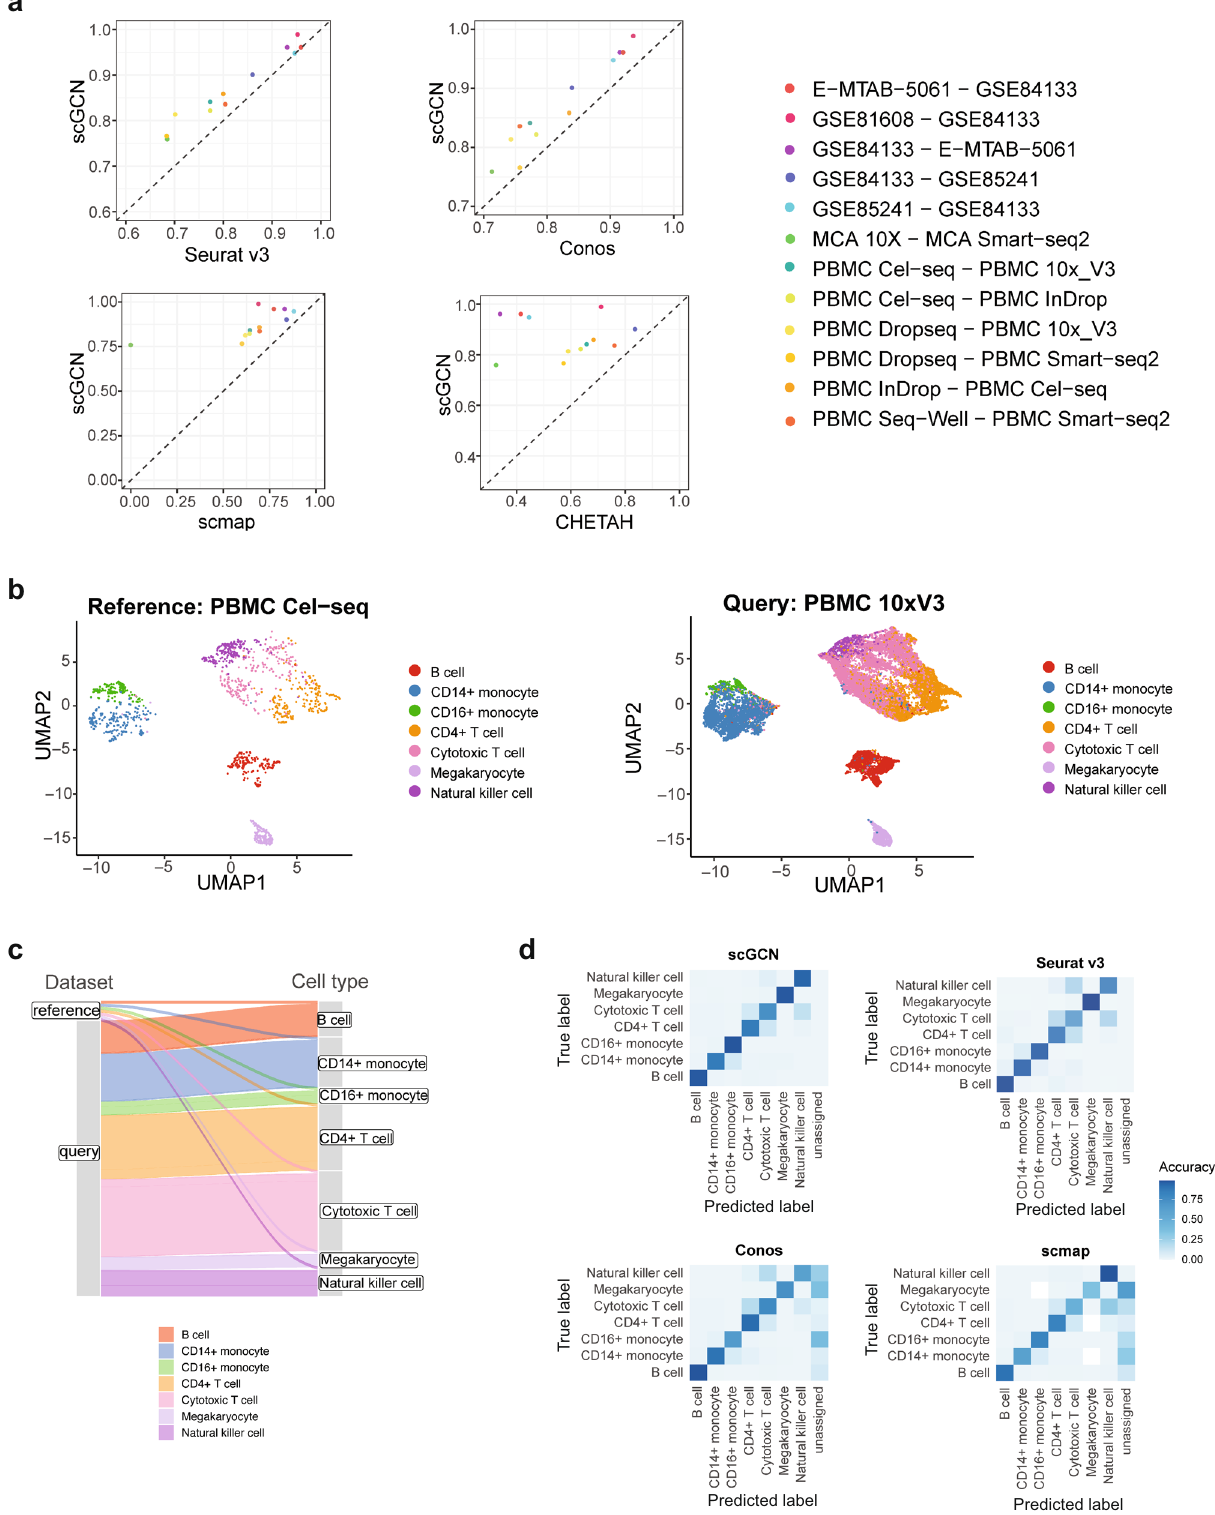
Fig. 3 Performance of scGCN and its comparison with other methods using 12 cross-platform datasets. a Performance of scGCN and alternative methods are measured by the accuracy score for 12 paired datasets. Each pair of reference-query datasets is pro fi led using different single-cell platforms. Each point represents the accuracy score for the query data of each paired datasets. b scGCN produces the UMAP projection of cells from Cel-seq as the reference to annotate cells from 10× V2 as the query dataset. c The height of linage line in the Sankey diagram re fl ects the cell number of each cell type in the reference data and query data. d Heatmap shows the accuracy matrix of each cell type identi fi ed by different methods based on the Cel-seq data as reference and the 10× V2 data as the query dataset. Source data are provided as a Source Data fi